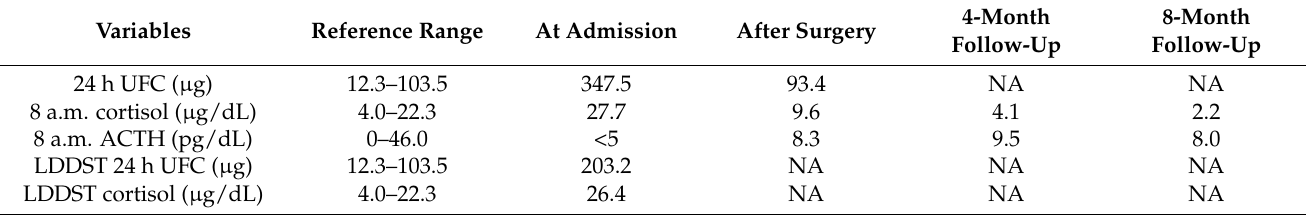
Table 1. Laboratory results of the patient.